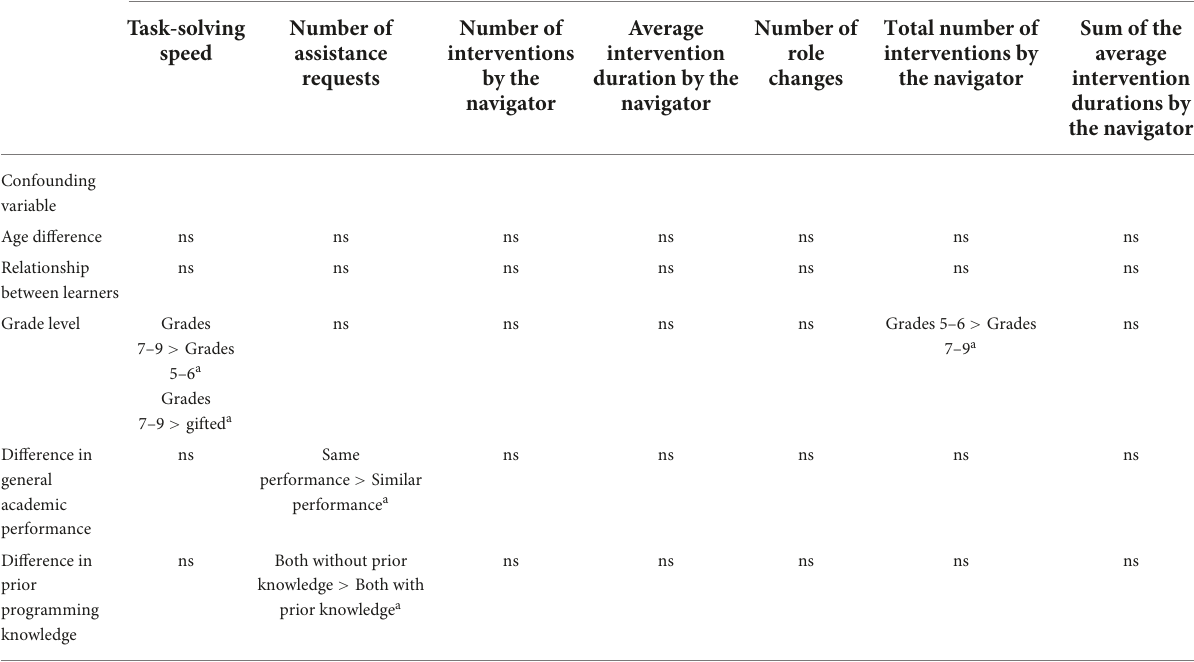
TABLE 4 Summary of the influences of the confounding variables on the dependent